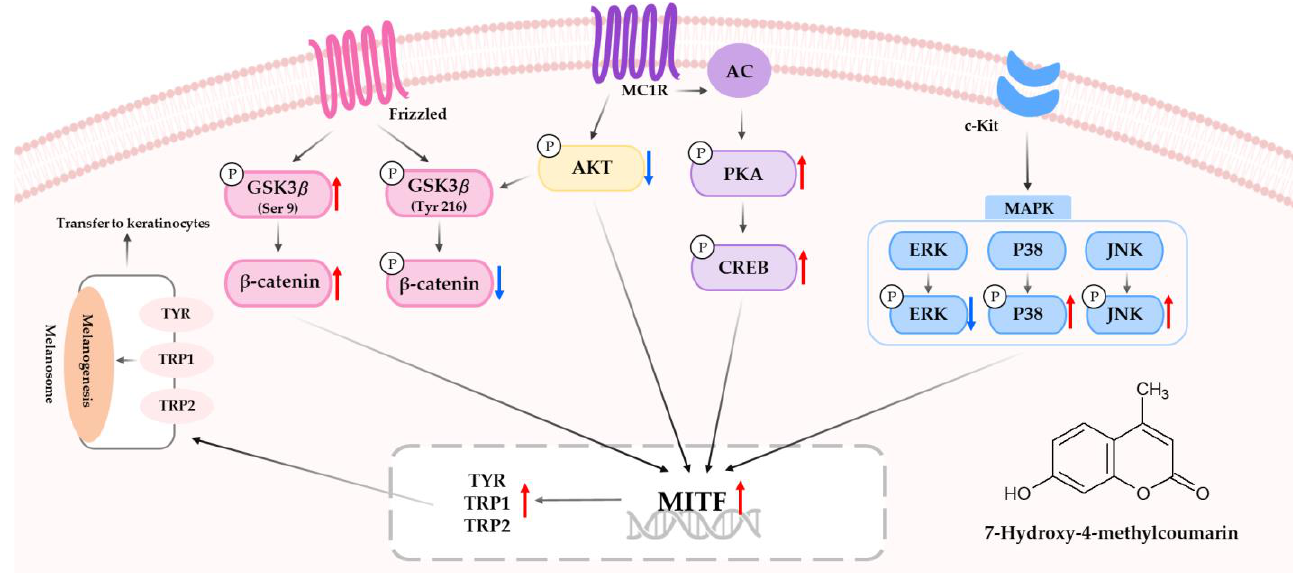
Figure 10. Schematic diagram of the proposed mechanism regulating action of 7H-4M on melano- Figure genesis.